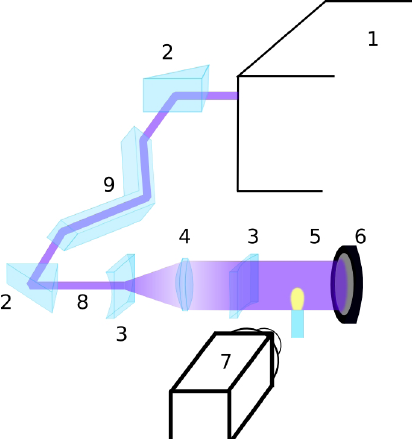
Figure 1: Experimental setup: 1 - dye laser with frequency doubling unit, 2 - right-angle prism, 3 - cylindrical negative lens, 4 - spherical positive lens, 5 - surfatron, 6 - laser power meter, 7 - ICCD detector, 8 - laser beam, 9 - Fresnel rhomb (turns